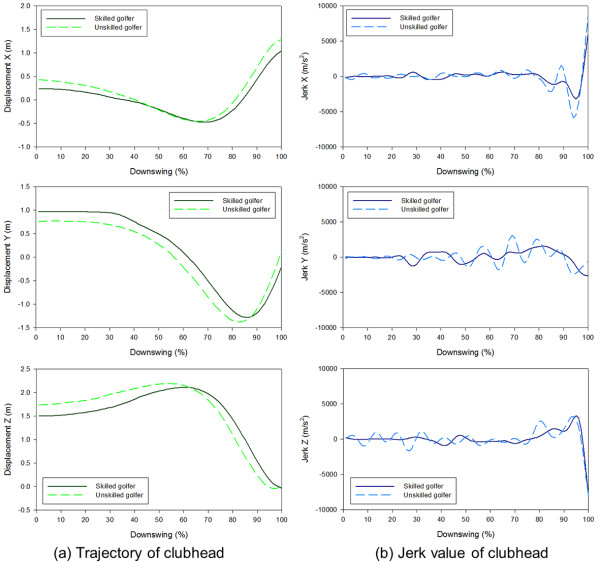
Clubhead trajectory and jerk of representative skilled (a) and unskilled (b) golfers during the downswing. The upper, middle and lower panels represent the values of x-, y- and z-axis of the local reference system respectively.